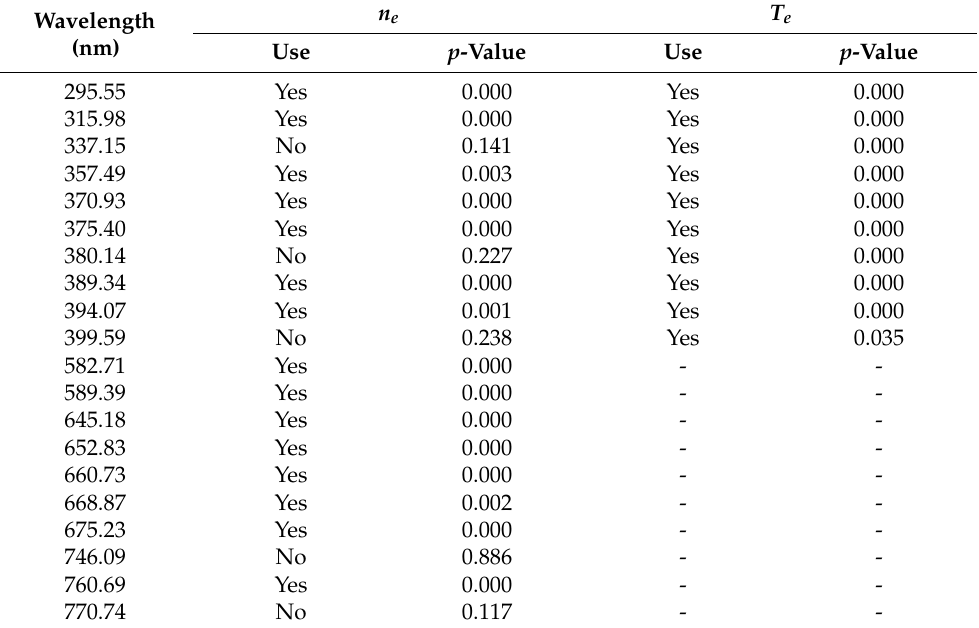
Table 4. The optimized wavelengths for predicting electron density and electron temperature in the MLR